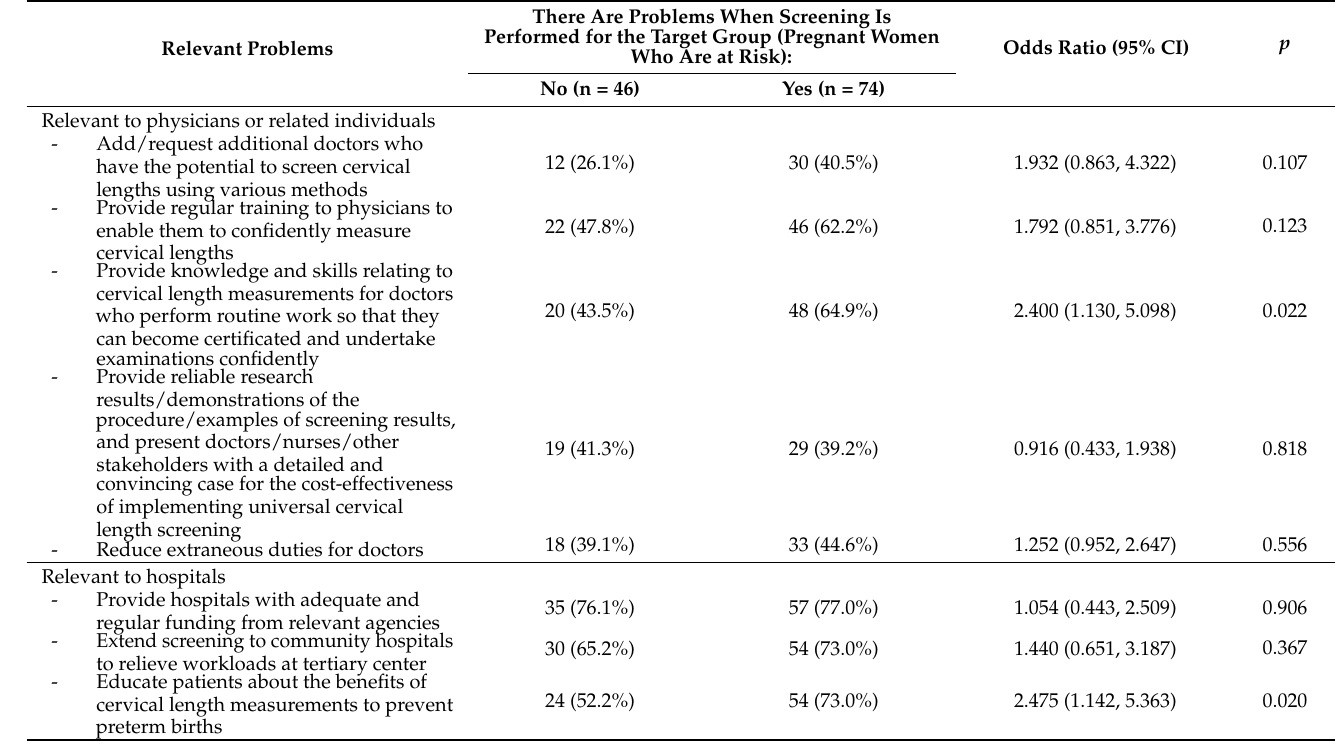
Table 6. Relevant problems when screening is performed for high-risk pregnant